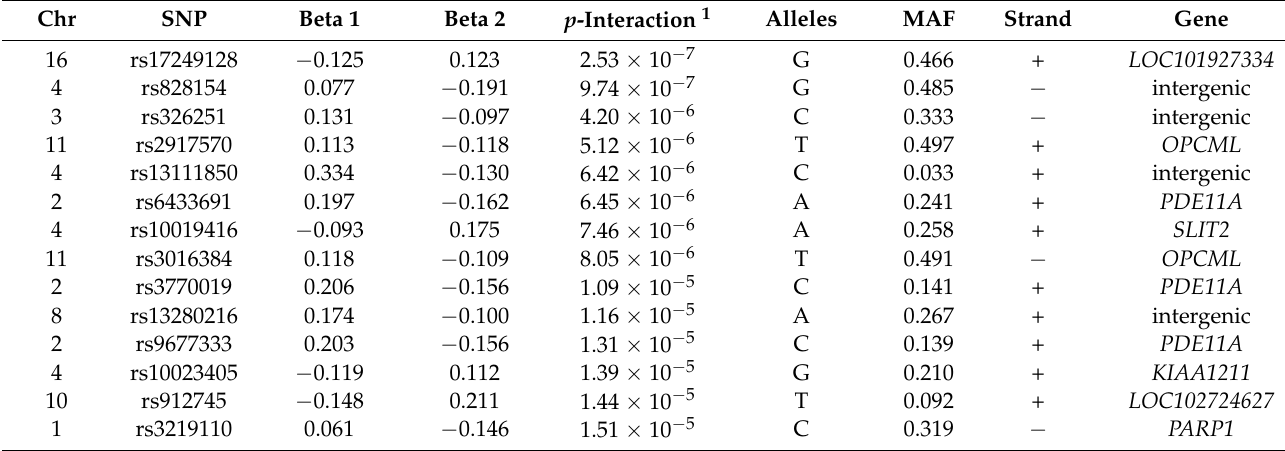
Table 7. Top-ranked SNPs of the GWAS for gene-diet interactions between the genome-wide SNPs and adherence to the Mediterranean diet in determining adiponectin concentrations (ln-transformed) in the whole